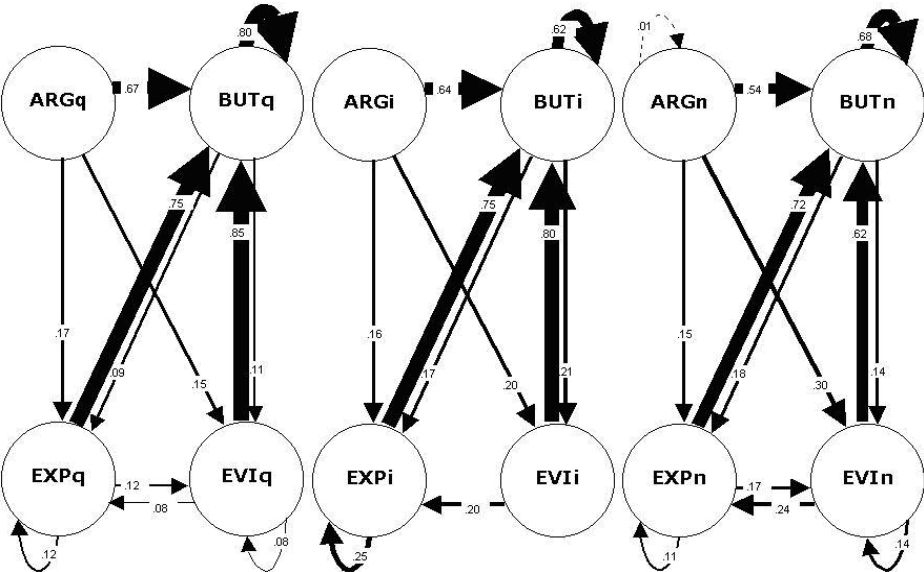
Figure 4. State diagrams of response patterns between message categories within